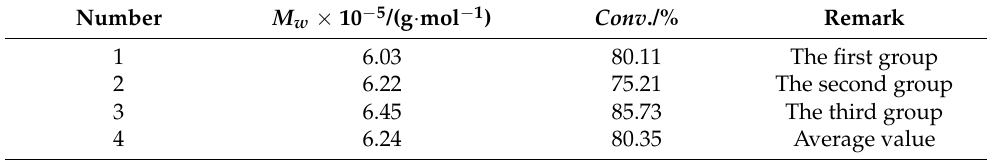
Table 4. Parallel verification of optimal process conditions for optimization of feed ratio factors.